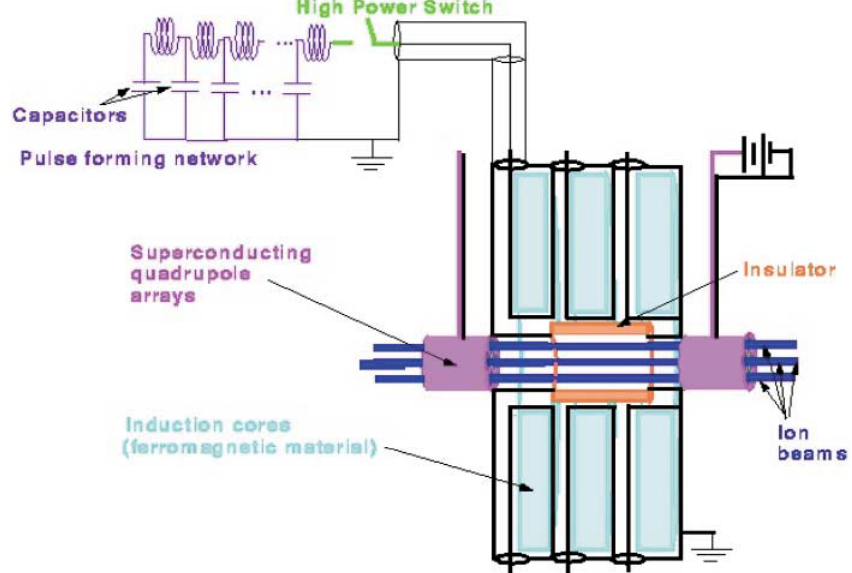
FIG. 1. (Color) Major components of an induction linac.